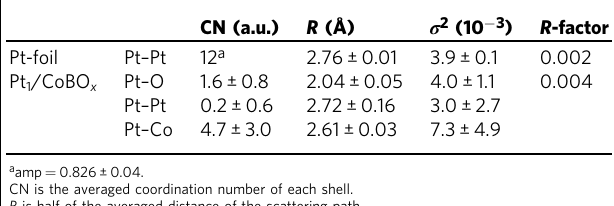
Table 1 Structural parameters of catalysts and Pt foil from the EXAFS fi